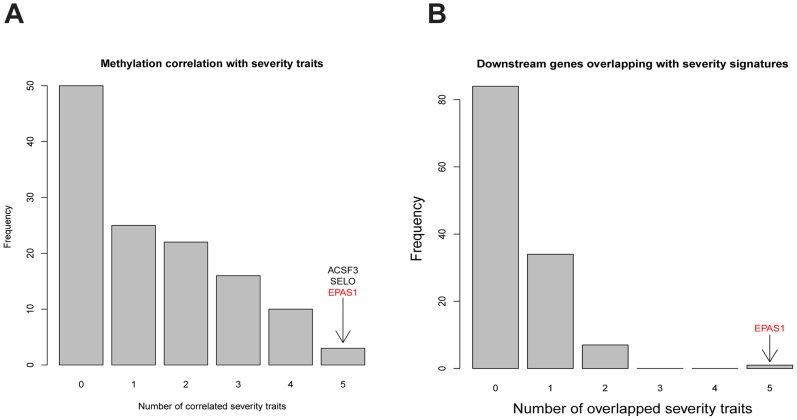
Comparing characteristics of key regulators with 5 COPD severity related traits in LGRC.
A) Comparing lung DNA methylation profiles of key regulators with 5 COPD severity related traits by Spearman correlation. At the Fisher's exact test p-value <0.05, the DNA methylation level variations of 3 key regulators, ACSF3, SELO, and EPAS1, were correlated with all 5 COPD severity related traits. B) Comparing downstream genes of key regulators with gene signature sets for 5 COPD severity related traits by the hypergeometric test. At the Fisher’s exact test p-value<0.05, only the key regulator EPAS1's downstream genes significantly overlapped with gene signature sets for all 5 COPD severity related traits.